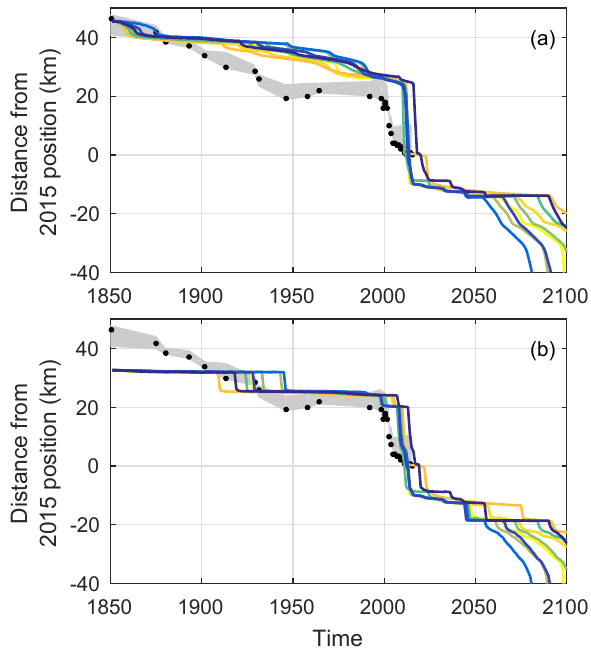
Figure 5. Simulated position of (a) the front and (b) the ground- ing line (GL) for nine different gradual forcing combinations pre- sented in Table 2. The colors for the different model runs are ran- dom. Black dots show the observed front positions at the centerline with a spread (gray shading) corresponding to the across-fjord vari- ation of each front position (Fig.